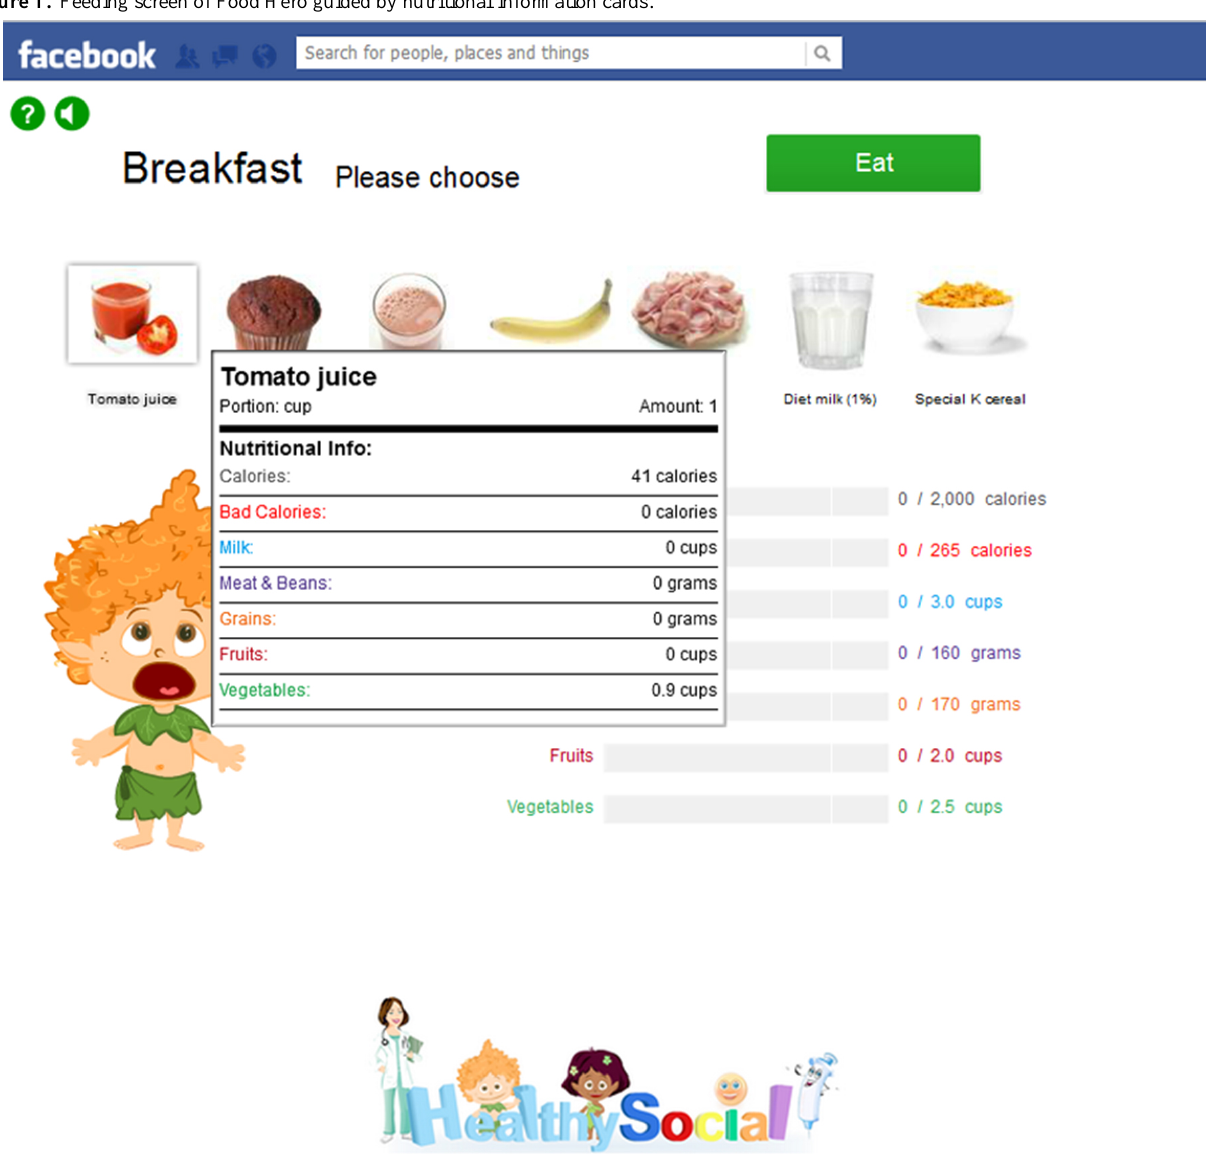
Figure 1. Feeding screen of Food Hero guided by nutritional information